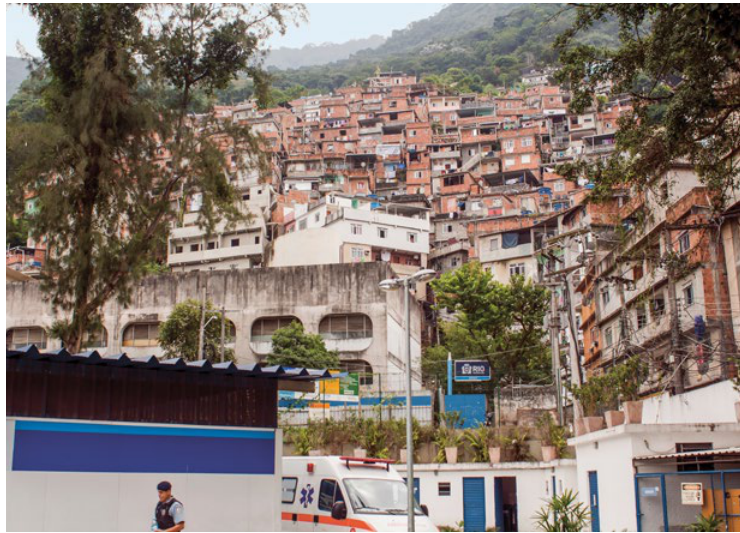
Figure 4 An example of a compact CIEP on a difficult site: the CIEP Doutor Bento Rubião in Rocinha, Brazil’s largest favela. Image © Aberrant